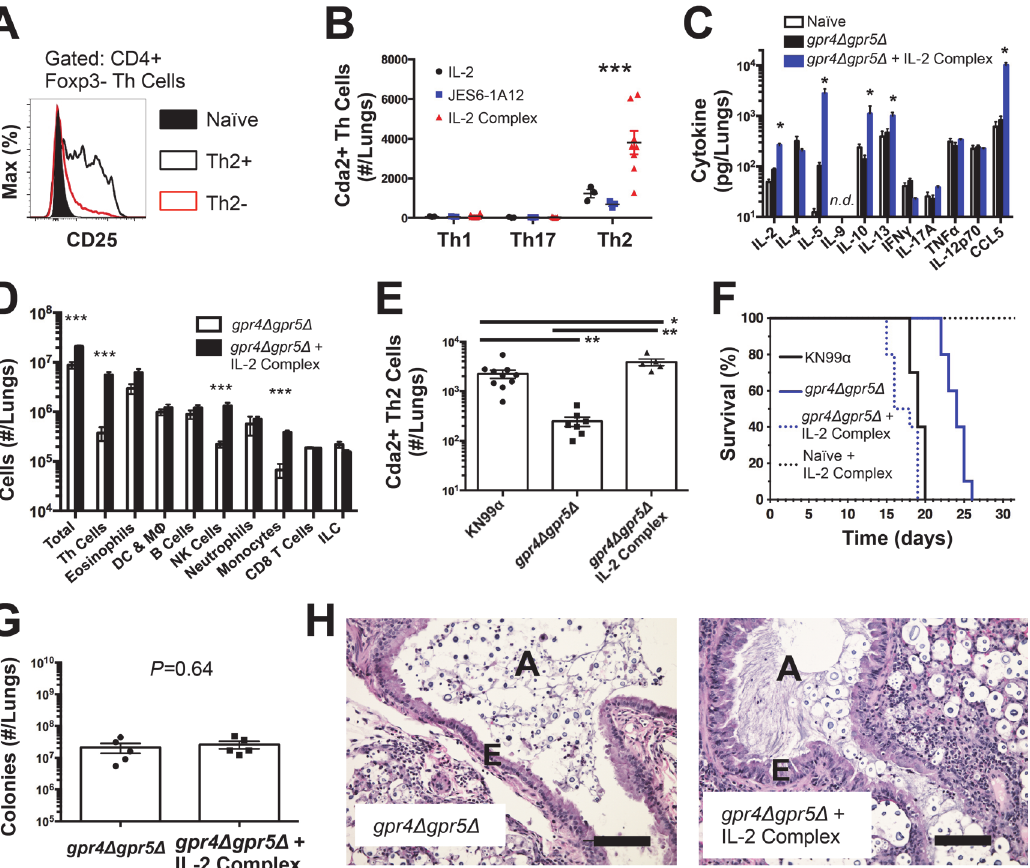
Fig 2. IL-2 Complexes Augment Type-2 Helper T Cells and Enhance Fungal Disease. ( A ) CD25 expression by na ï ve (CD4+, CD44 − ), Th2- (CD4+, CD44+, IL-5-, IL-13 − ), and Th2+ (CD4+, CD44+, IL-5+, IL-13+) cells. ( B ) Cda+ Th cell numbers in the lungs of gpr4 Δ gpr5 Δ infected mice treated with 5 μ g IL- 2, 25 μ g anti-IL-2 antibody (JES6-1A12), or both (IL-2 Complex). Th1, Th17, and Th2 cells were identified by production of IFN γ , IL-17A, and IL-5/13, respectively. ( C ) Cytokines from lung homogenates of mice infected with gpr4 Δ gpr5 Δ or age-matched na ï ve animals, with or without IL-2 complex treatment. ( D ) Pulmonary leukocytes from mice infected with gpr4 Δ gpr5 Δ , with or without IL-2 complex treatment. ( E ) Cda2+ Th2 cells from lungs of mice infected with fully virulent KN99 α , attenuated gpr4 Δ gpr5 Δ , or mice infected with gpr4 Δ gpr5 Δ and treated with IL-2 complex. ( F ) Survival of na ï ve mice or mice infected with gpr4 Δ gpr5 Δ either with or without IL-2 complex treatment. P -value represents log-rank test comparing each survival curve with 10 mice per group to: gpr4 Δ gpr5 Δ vs. gpr4 Δ gpr5 Δ + IL-2 complex, P < 0.0005; gpr4 Δ gpr5 Δ vs. KN99 α , P < 0.0005; gpr4 Δ gpr5 Δ + IL-2 complex vs. KN99 α , P = 0.23. ( G ) Fungal burden within lungs of mice with or without IL-2 complex 14 days post-infection with gpr4 Δ gpr5 Δ . ( H ) Hematoxylin and eosin staining of lungs from mice infected with gpr4 Δ gpr5 Δ or similarly infectedand treated with IL-2 complexes. A = brochialairway, E = epithelialcell layer. Data are presented as themean +/- standard error with at least 2 independent experiments per group. * = P < 0.05, ** = P < 0.005, *** = P < 0.0005 by Mann-Whitney U . Cda = chitin deacetylase, CCL = chemokine ligand, DC = Dendritic Cells, IFN = interferon, IL = interleukin, ILC = Innate Lymphoid Cells, M Φ = Macrophages, NK = Natural Killer. TNF = tumor necrosis